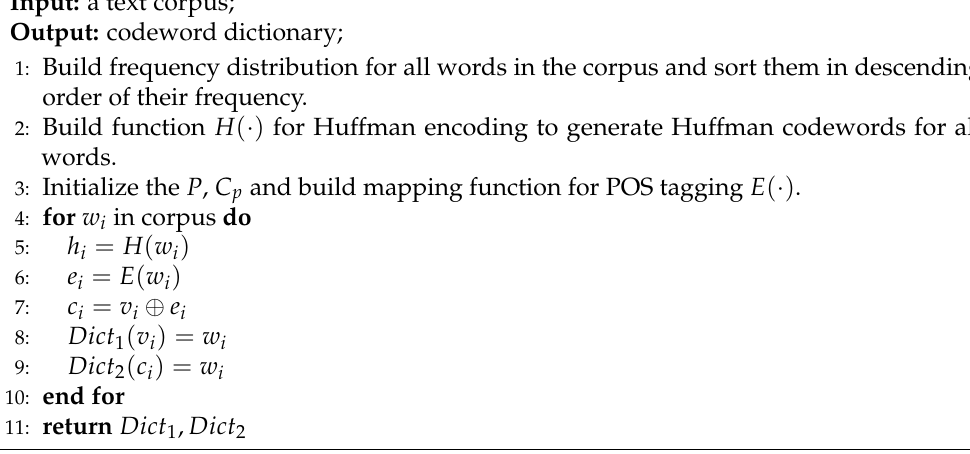
Algorithm 1 Part-of-speech-based encoding